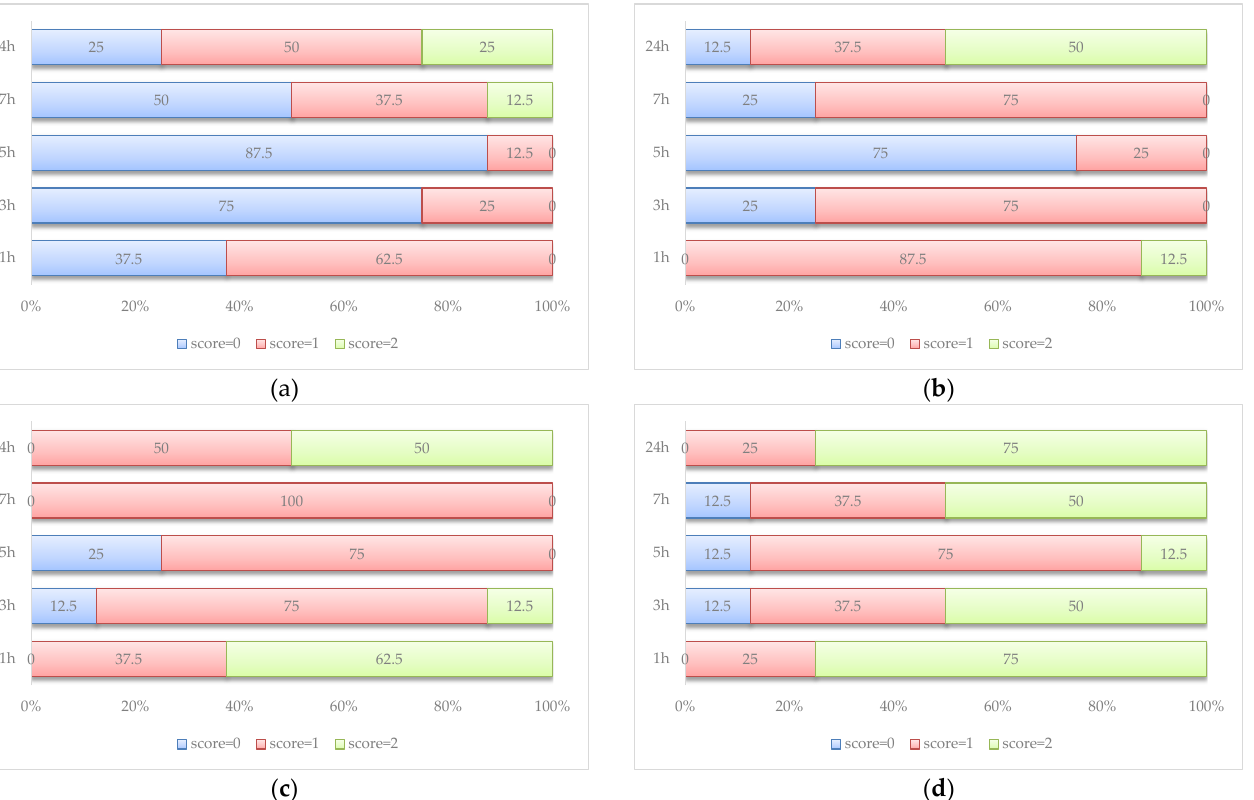
Figure 5. Variation of measurements obtained by paw pressure test (PPT, left graph) and hot plate test (HPT, right graph) by group (1 = C, 2 = AI, 3 = AI-D, 4 = AI-GRCE100, 5 = AI-GRCE200, 6 = AI- GRCE100-D, 7 = AI-GRCE200-D). The best motility is observed in the rats in the AI-GRCE200-D group (Figure 6). Nor- mal motility at 24 h was observed on 6/8 rats in the AI-GRCE200-D group, while half of the rats in the AI-GRCE200 and AI-GRCE100-D groups showed normal motility at the same measurement.